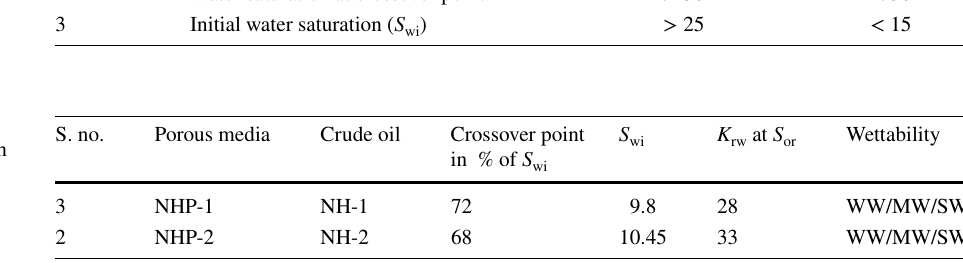
Table 2 Rules of thumb for wettability inference from oil– water relative permeabilities during imbibition process by Craig (1971)